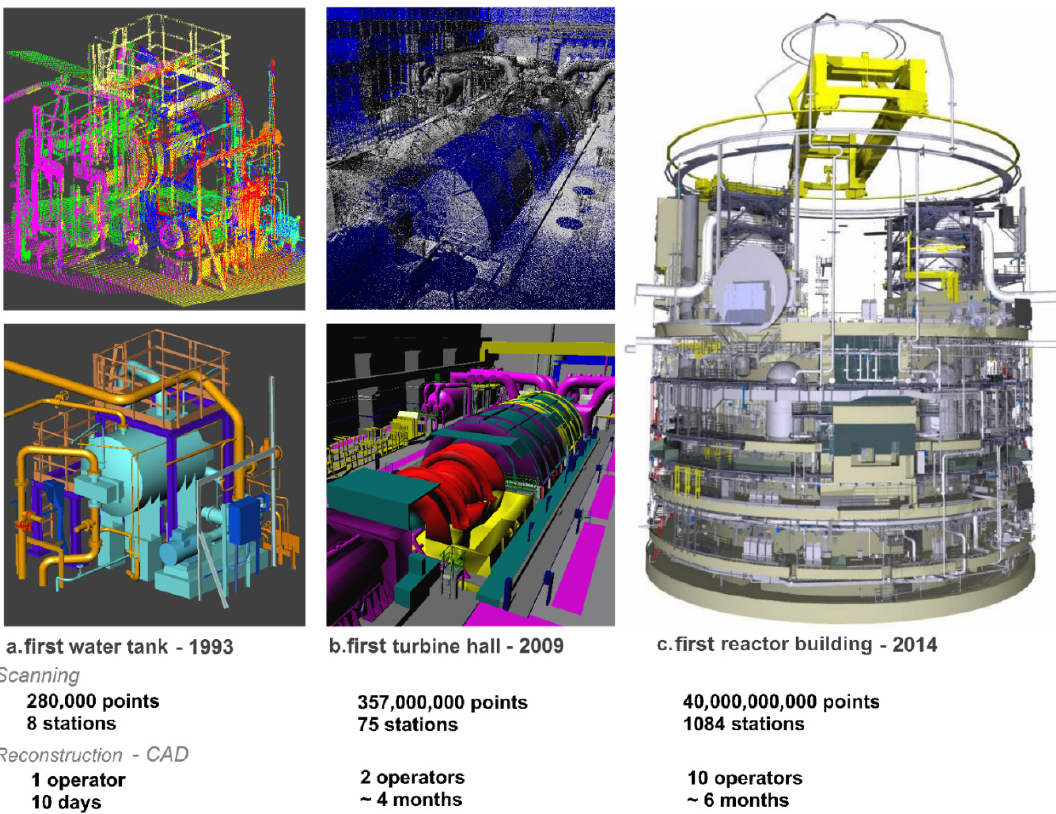
Figure 1. Review of three breakthrough projects (1993–2014) of as-built reconstruction from laser scanning data of industrial facilities at Electricité de France (EDF) [1]: ( a ) first water tank (1993); ( b ) first turbine hall (2009); ( c ) first reactor building (2014).